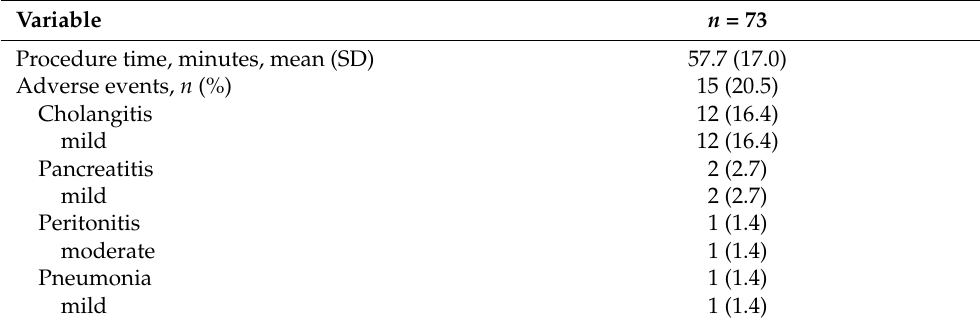
Table 2. The procedure time and adverse events per electrohydraulic lithotripsy